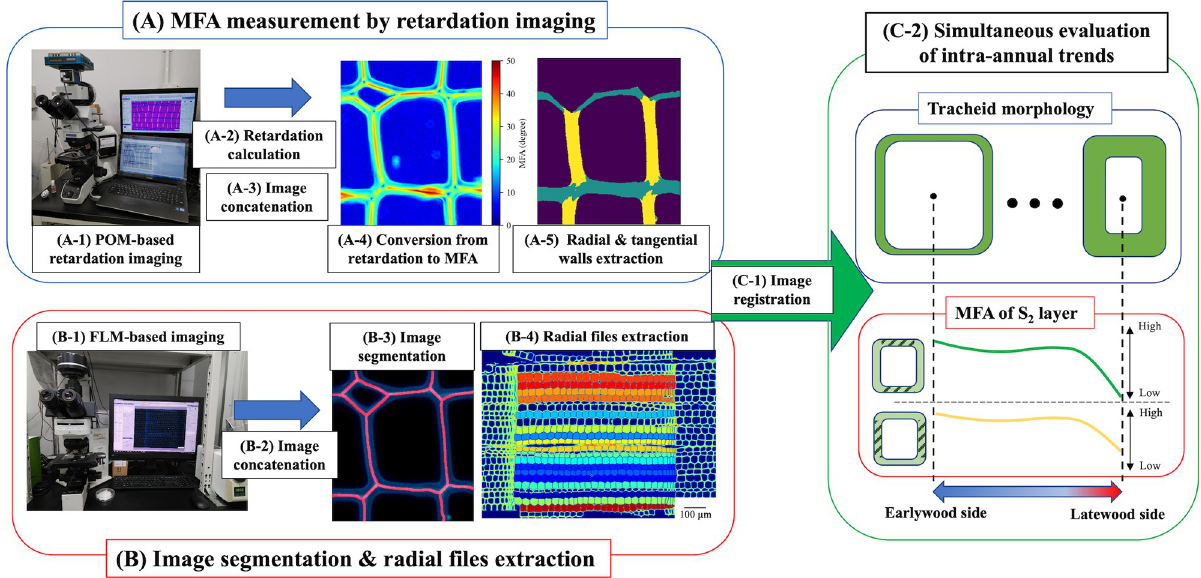
Fig 1. Experimental flows for image detection and analysis. The S 2 microfibril angle (MFA) values of radial and tangential walls were obtained from polarization optical microscopy (POM)-based imaging (step A). Tracheid morphology in a radial file unit was extracted from fluorescence microscopy (FLM)-based imaging and image analyses (step B). Finally, the two results were integrated to simultaneously evaluate S 2 MFA and tracheid morphology (step C). Details of each experimental step are explained in the main text.